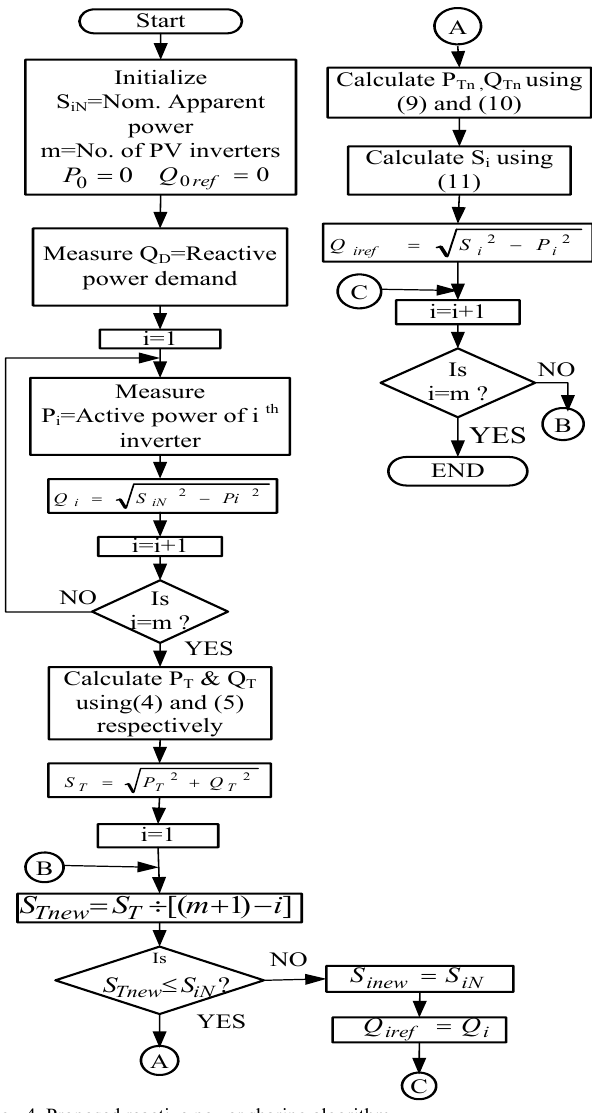
Fig. 4. Proposed reactive power sharing algorithm